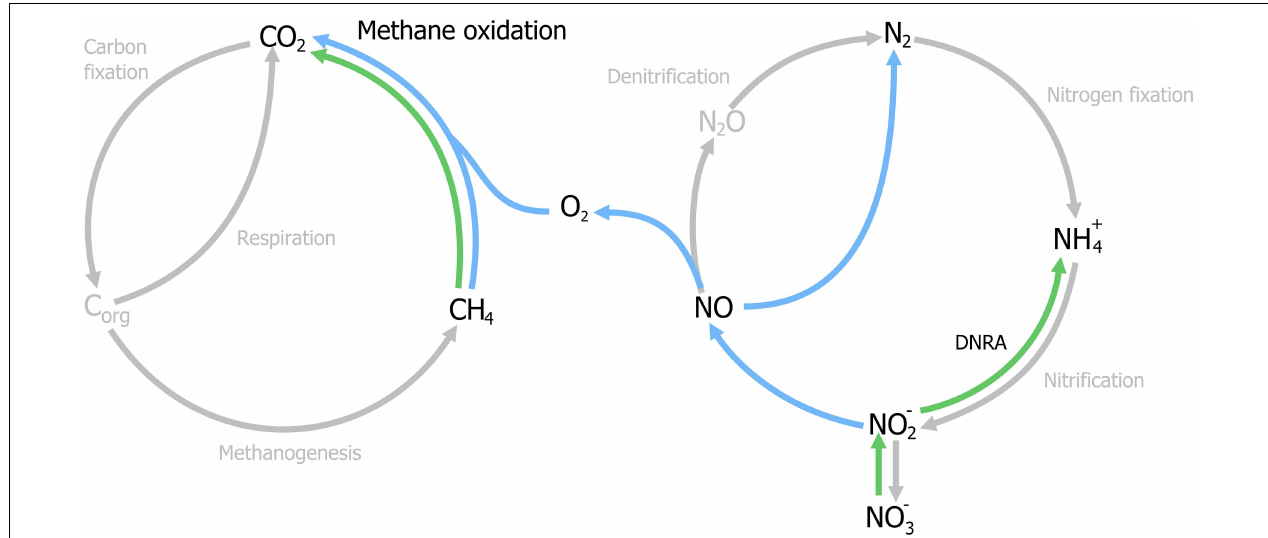
FIGURE 3 | Schematic representation of the nitrate- and nitrite-dependent Anaerobic Oxidation of Methane (N-dAOM). Methylomirabilis bacteria (process in blue) reduce nitrite and through an intra-aerobic pathway, oxidize methane to CO 2 . “ Ca. M. nitroreducens ” (process in green) reduce nitrate, with nitrite as an intermediate, while oxidizing methane anaerobically using nitrate as terminal electron acceptor. Furthermore, Methanoperedens archaea are capable of producing ammonia through dissimilatory nitrate reduction (DNRA).